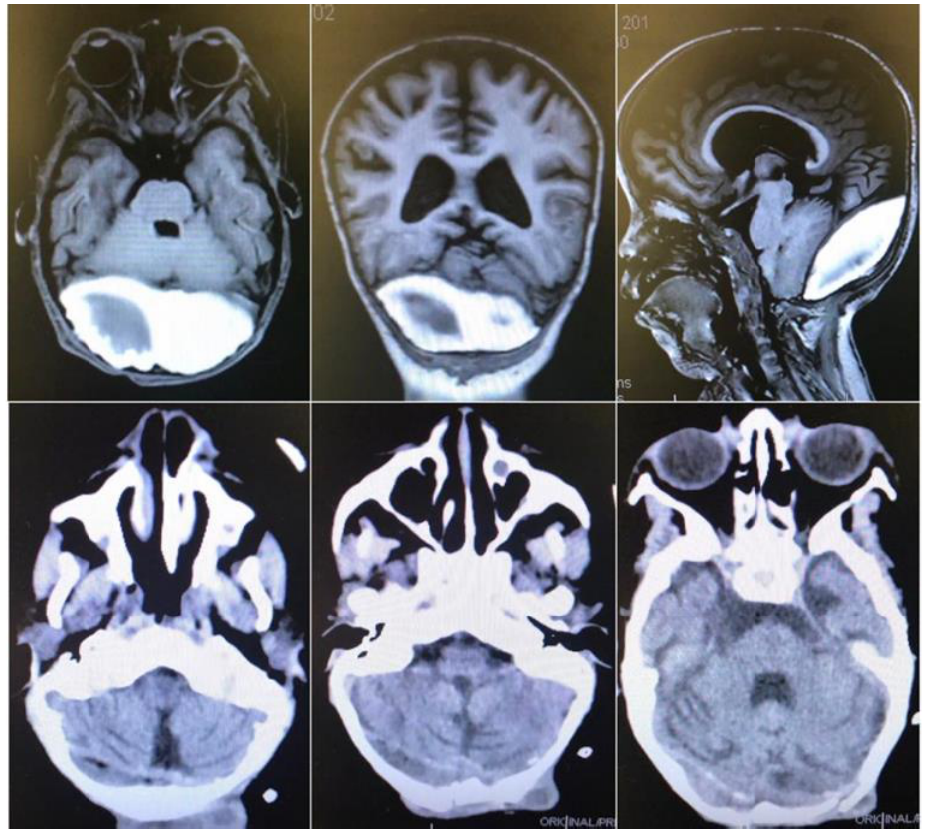
Fig 1. ABOVE - Magnetic resonance imaging (MRI) T1 weighted in axial, coronal and sagittal view demonstrating extensive heterogeneous biconvex subacute epidural hematoma in the posterior fossa. BELOW - postoperative brain computed tomography scan (CT) in axial view demonstrating complete hematoma